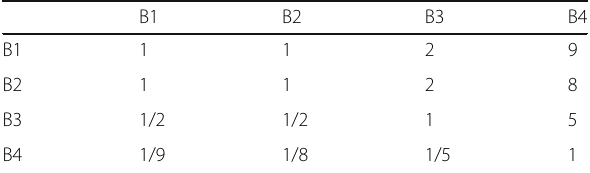
Table 8 Weight of level indicators. (Source: Authors)